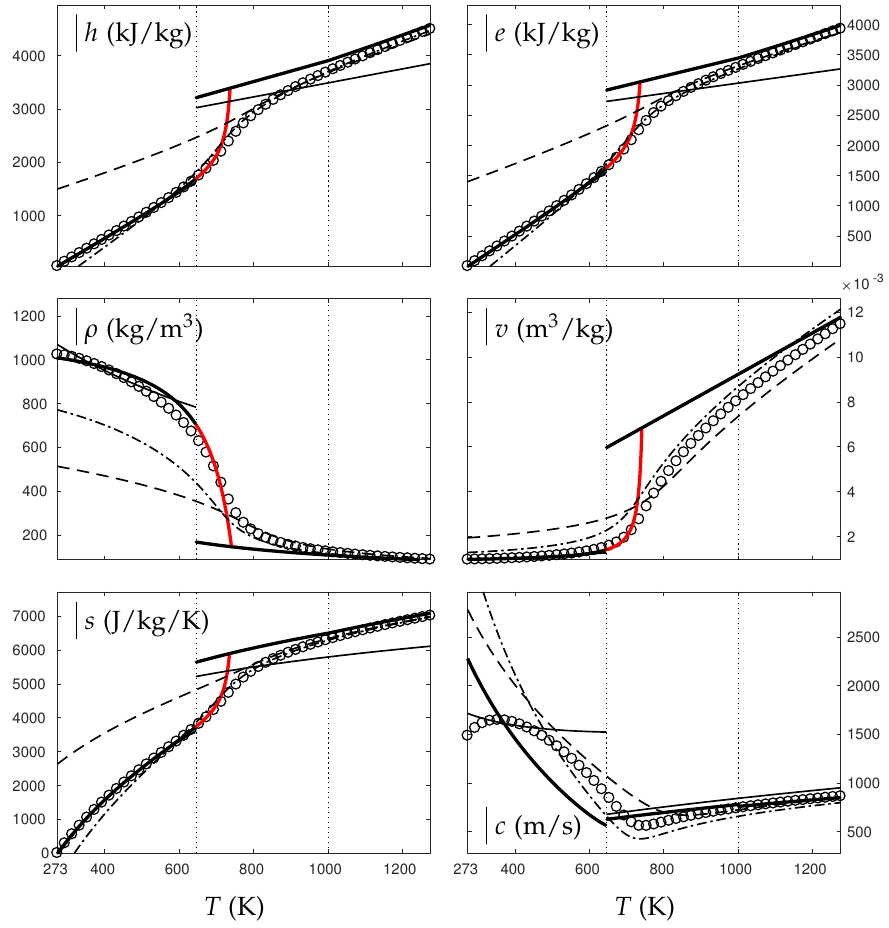
Figure 5. Comparison between experimental and theoretical isobar for water. The symbols represent the experimental isobar p = 500 bars. Beyond the critical temperature T c = 646 K, the liquid transforms to supercritical state. The thick solid lines represent the Extended NASG (ENASG) EOS, reducing to the ideal gas description for the supercritical phase, Equations (56), (57) and (60). The thin solid lines represent the original NASG EOS also reducing to the ideal gas formulation for the supercritical phase. The dashed lines represent the van der Waals (VdW) theoretical predictions and the dashed-dotted lines represent the Soave–Redlich–Kwong (SRK) ones. The critical temperature is indicated with the dotted lines. From this temperature, the liquid ENASG EOS is extended and joins the ideal gas EOS (except for the sound speed). The temperature T 0 = 1000 K at which variable heat capacities are considered is indicated in dotted lines as well.